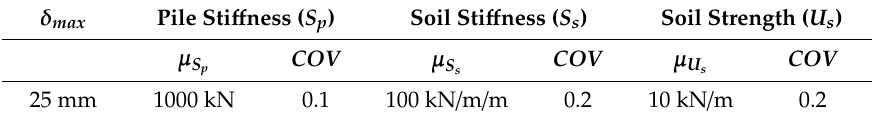
Table 1. Input data abstracted by Fenton and Gri ffi ths [21], referred to as “reference data”. δ ff ness ( S max Pile Sti p